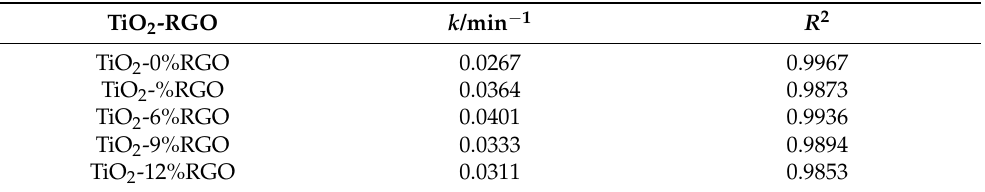
Table 1. Kinetic parameters of methyl orange degradation by TiO 2 -RGO with different GO con- tents.